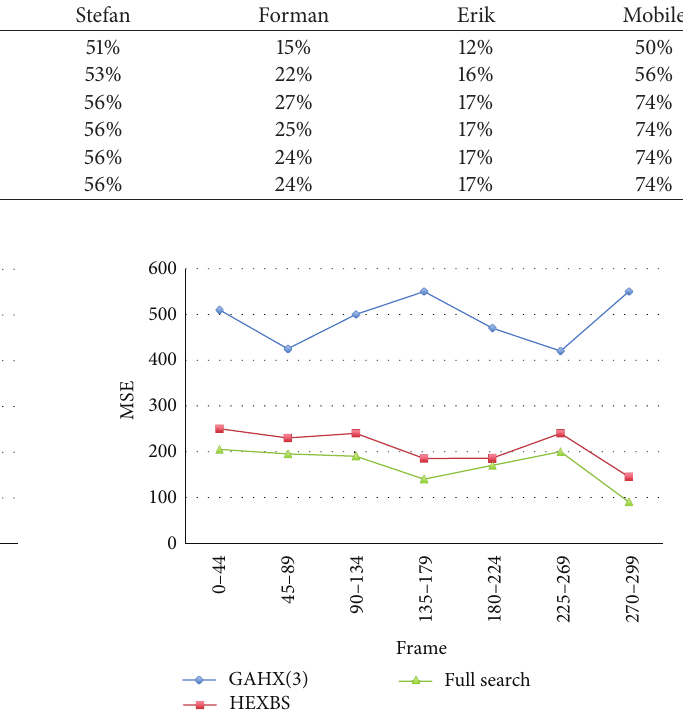
Figure 24: Average MSE per block compared with different meth- ods for Mobile video sequence.